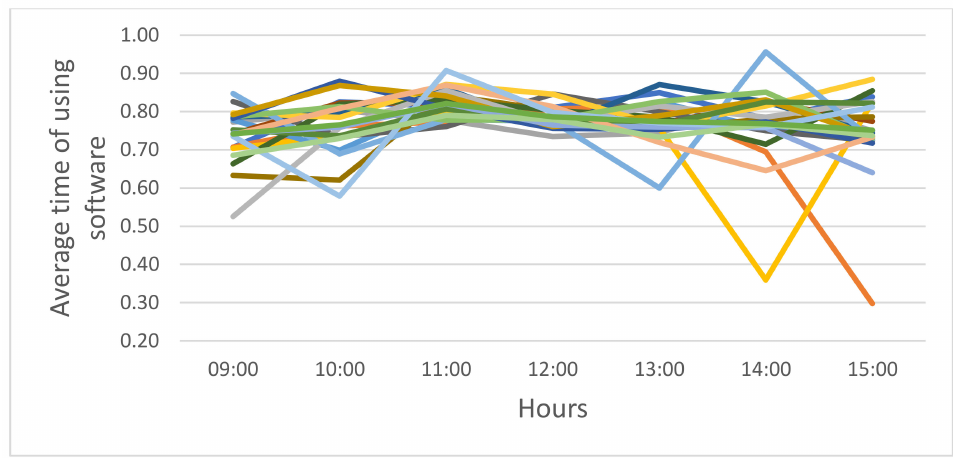
Figure 7. Average time users spent accessing the software in hours with each color representing a